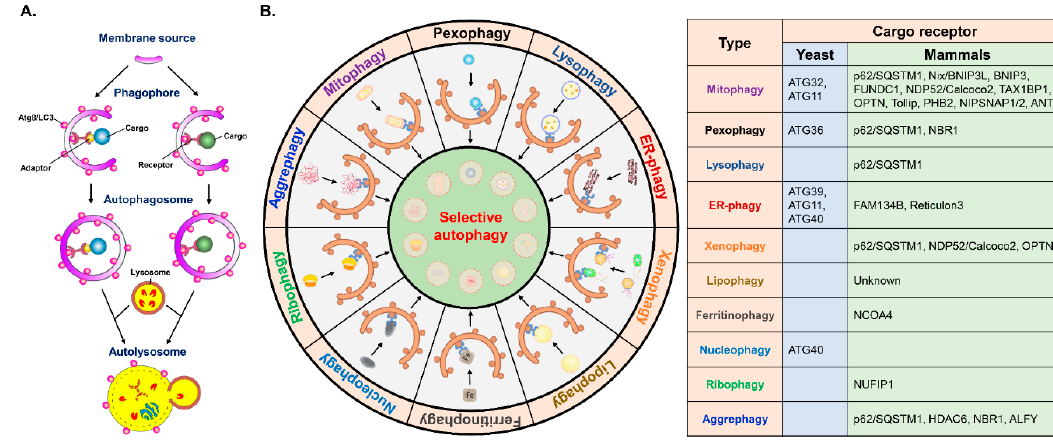
Figure 2. Regulation of selective autophagy by cargo receptors. ( A ) Selective autophagy is an elimination process that involves the targeting of cargoes to the autophagy machinery by the specific receptor proteins that contain an ATG8/LC3-interacting regions (LIRs) for the interaction with ATG8/LC3 located on the membrane of the IM/phagophore. Another type of selective autophagy is mediated by the interactions between adaptor proteins with cargo receptors and ATG8/LC3. The IM/phagophore encloses mature autophagosomes that fuse with lysosomes to form autolysosomes, in which the engulfed cargoes are degraded. Ubiquitination of cargo and/or the binding to additional adaptor proteins mediate the recognition of cargoes and cargo receptors. ( B ) Selective autophagy participates in the degradation of damaged organelles and aggregated proteins. Several mammalian and yeast cargo receptors have been identified to eliminate the dysfunctional mitochondria, damaged lysosomes, injured peroxisomes, stressed ER and infecting pathogens by selective autophagy (mitophagy, lysophagy, pexophagy, ER-phagy, and xenophagy, respectively). Moreover, other forms of cargoes, including LDs (lipophagy), ferritin (ferritinophagy), nucleus (nucleophagy), ribosome (ribophagy), protein aggregate (aggrephagy), are degraded by selective autophagy through a process mediated by identified and unknown cargo receptors. The yeast and mammalian cargo receptors responsible for each type of selective autophagy are listed in the